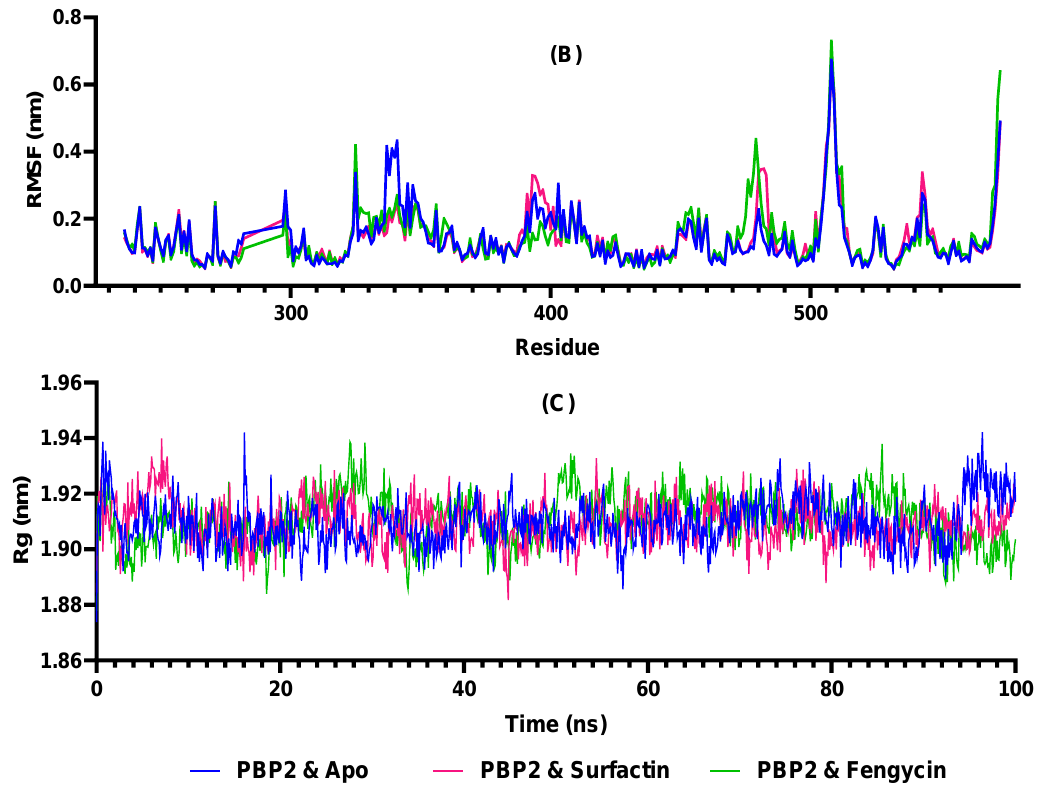
Figure 4. Molecular dynamics simulations of apoprotein (PBP2 and Apo), Surfactin (PBP2 and Surfactin) and Fengycin (PBP2 and Fengycin) complexes with penicillin-binding protein 2 (PBP2) ( A ) RMSD of apoprotein, Surfactin and Fengycin bound PBP2 complexes, ( B ) RMS fluctuation, and ( C ) Rg plots during the period of 100 ns simulation.